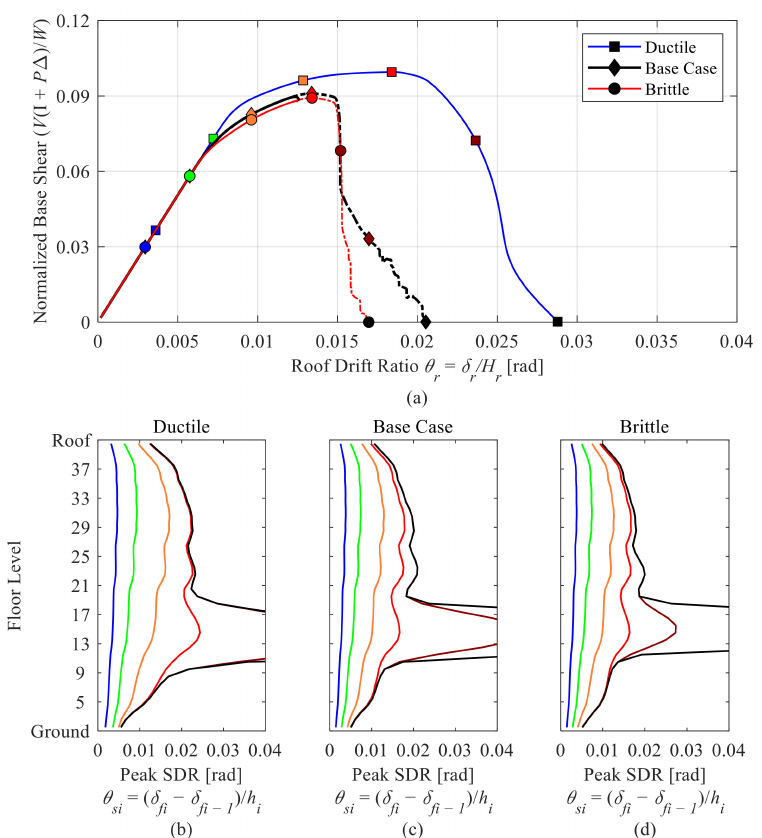
Figure 2. Comparison of pushover curves and story drift ratios for in the X-loading direction, ( a ) pushover curves, ( b ) story drift ratios for ductile case, ( c ) story drift ratios for base case, ( d ) story drift ratios for brittle